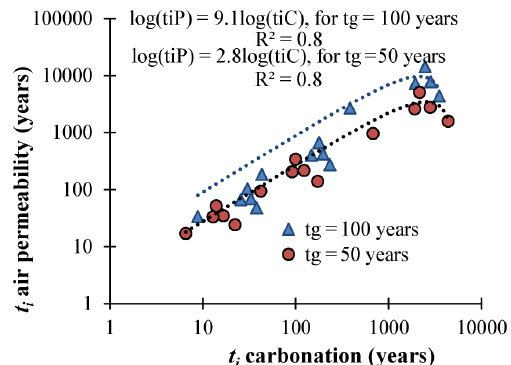
Fig. 6. Results of initiation period according to accelerated carbonation tests ( x - x ) and air permeability tests ( y - y ) for XC2, XC3 and XC4, for t g = 50 and 100